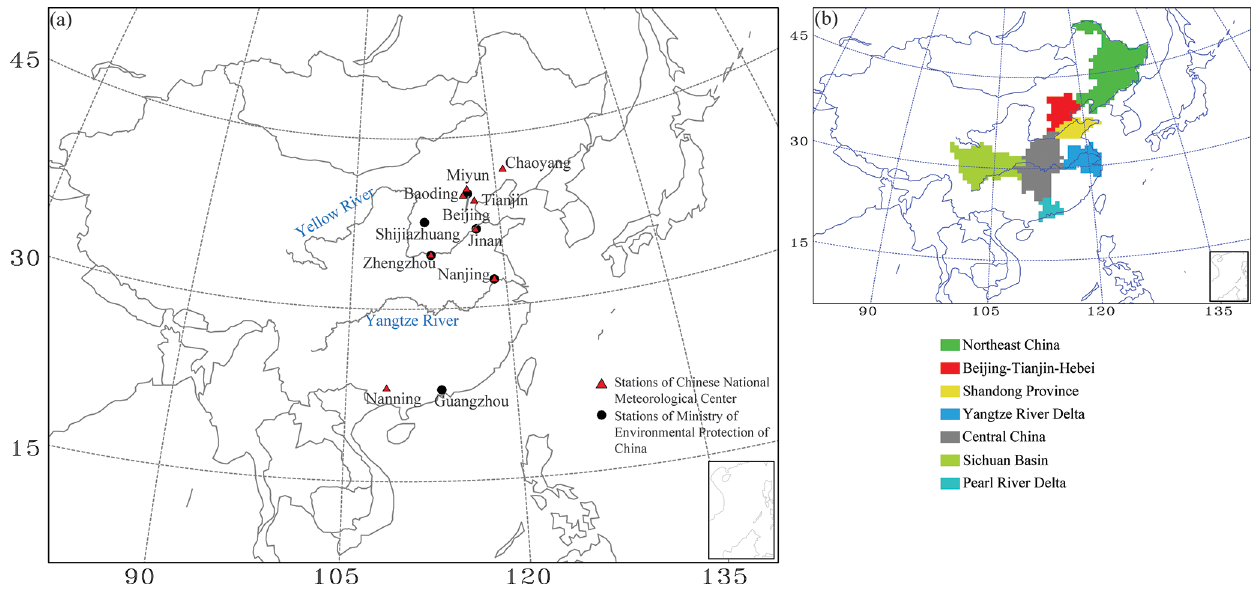
Figure 1. Model domain used in this study and the geographic locations of Beijing–Tianjin–Hebei (BTH), Northeast China (NEC), Yangtze River Delta (YRD), Pearl River Delta (PRD), Sichuan Basin (SCB), Central China (CNC), and Shandong Province (SDP). The locations of observation data are also shown in the model